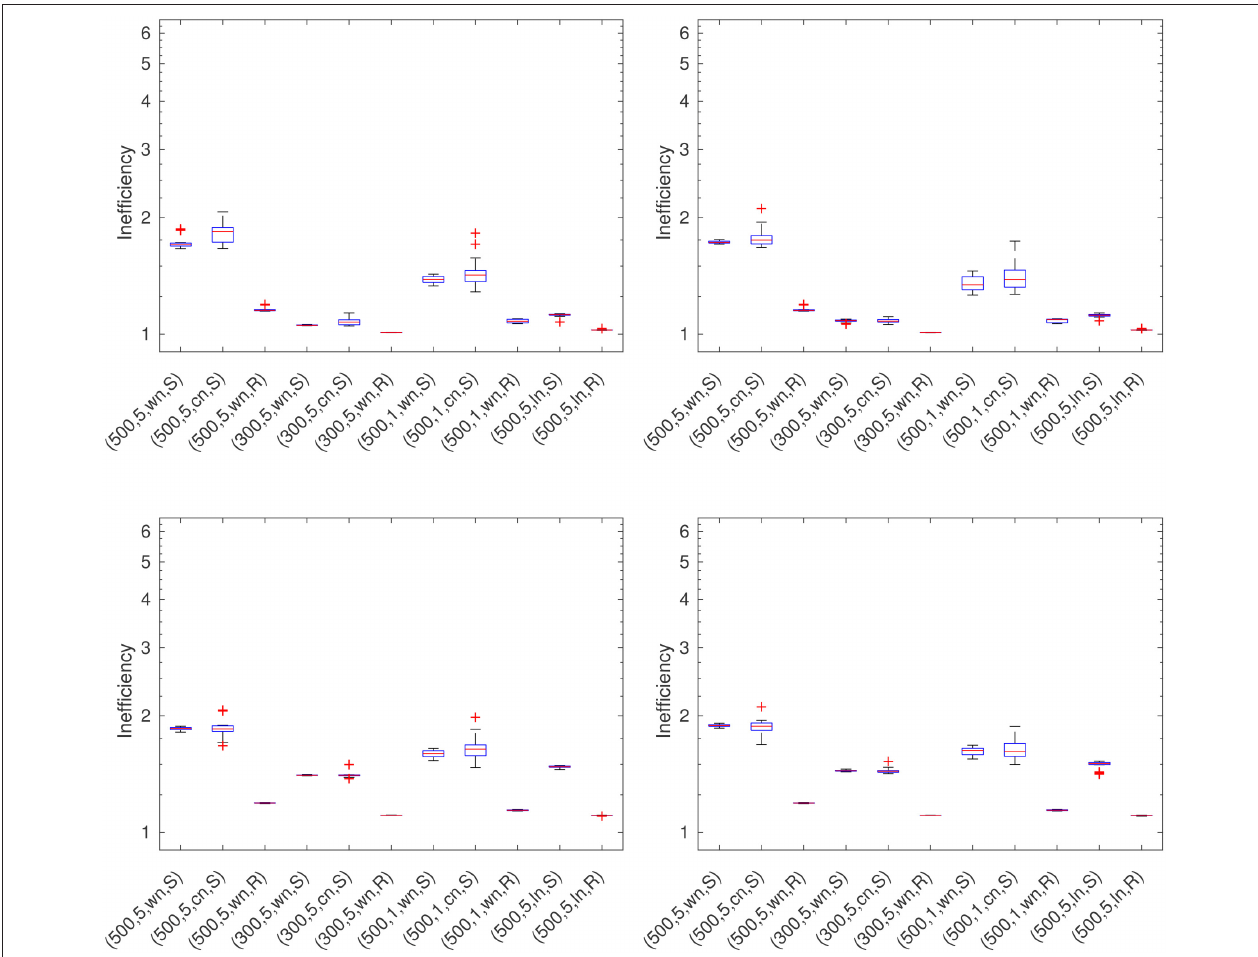
FIGURE 8 | RGCV for the RFMP (Left-hand top) and the ROFMP (Right-hand top) and SRGCV for the RFMP (Left-hand bottom) and the ROFMP (Right-hand bottom) .